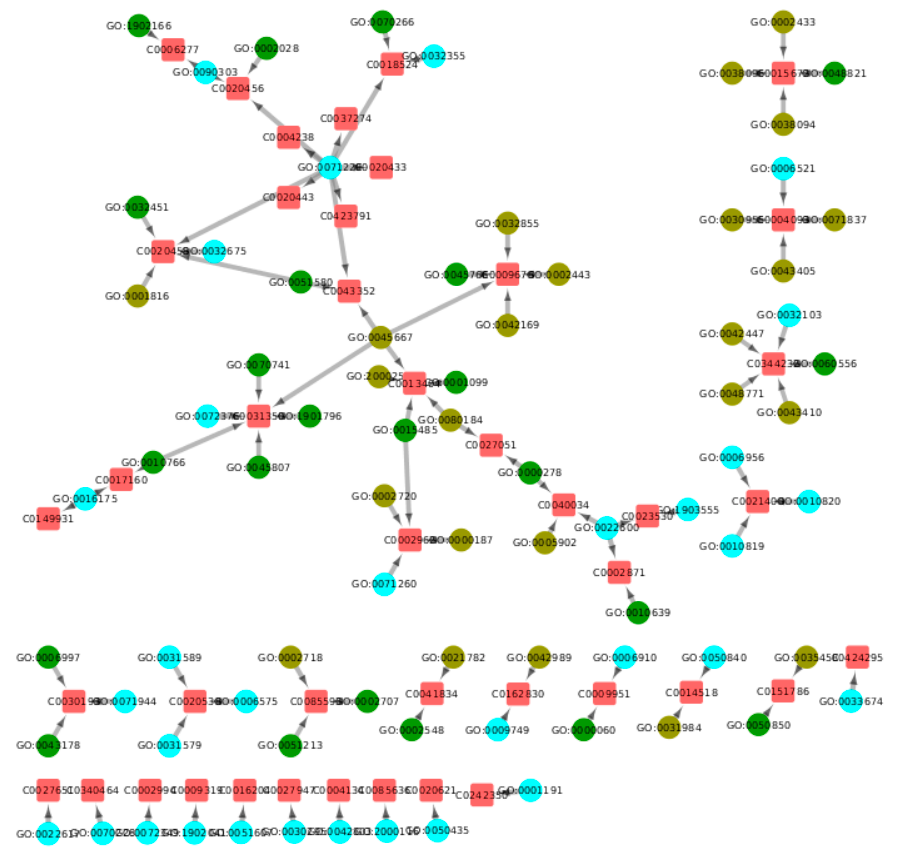
Figure 9. Fluoxetine–phenelzine drug combination network CRMs. This is a visualization of the CRMs for the phenelzine–fluoxetine combination. In this visualization, those GO terms associated only with phenelzine are light brown, those associated only with fluoxetine are dark green, and those associated with both are blue. The red squares represent cADRs. The largest CRM contains 20 different cADRs. The remaining 23 cADRs are independent of each other, each belonging to its own small CRM.